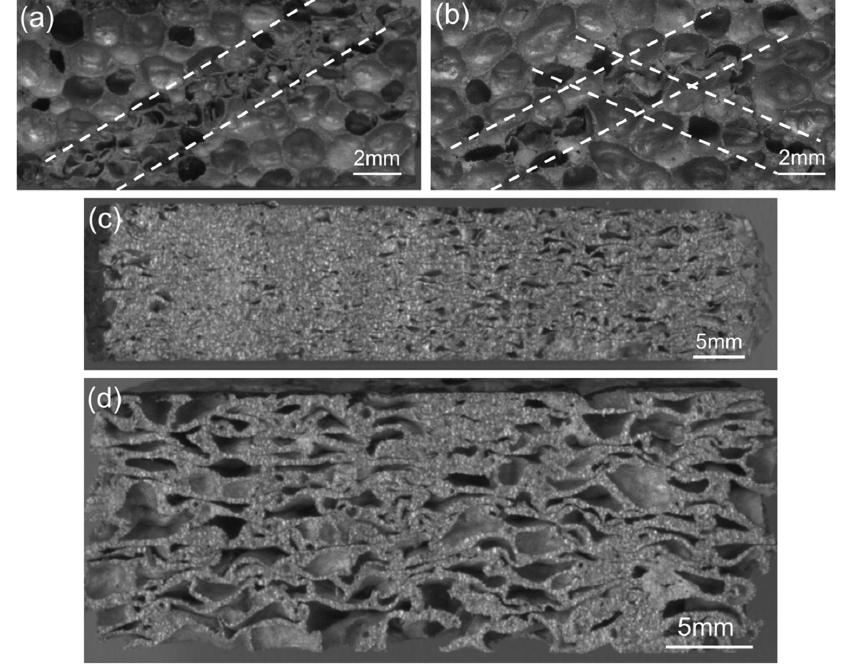
Figure 20. Typical deformation morphologies of specimens during uniaxial impact experiment ( a ) initial deformation band ( b ) X-shaped quasi-conjugate shearing deformation ( c , d ) post-impact morphologies of specimens with different densities.